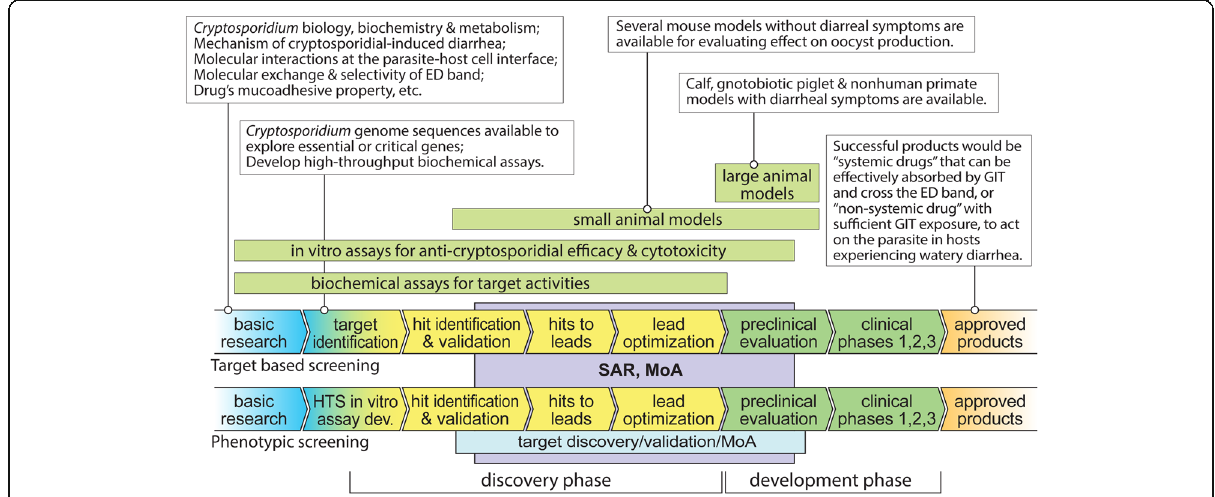
Fig. 3 Illustration and brief annotation of drug discovery pipeline, major assays and models in target-based and phenotypic screening approaches. Yellow and green boxes indicate discovery and developmental phases. In both approaches, structure-activity relationship (SAR) and mode of action (MoA) analysis may be started shortly after hits are identified and extended to later stages. In the phenotypic screening approach, discovery of target by the identified hit may be needed for determining MoA. Biochemical assays and in vitro assays may be developed in the basic research phase and used throughout the discovery phase, and extended into the preclinical phase. Small animal models are used in discovery and preclinical phases, while large animal models are used in preclinical phase. For drug discovery against cryptosporidiosis, it ’ s critical to discover efficacious systemic drugs that can be effectively absorbed by human or animal patients and cross electron-dense (ED) band at the parasite-host cell interface, or non-systemic drugs that have sufficient gastrointestinal tract (GIT) exposure for acting on the epicellular parasite